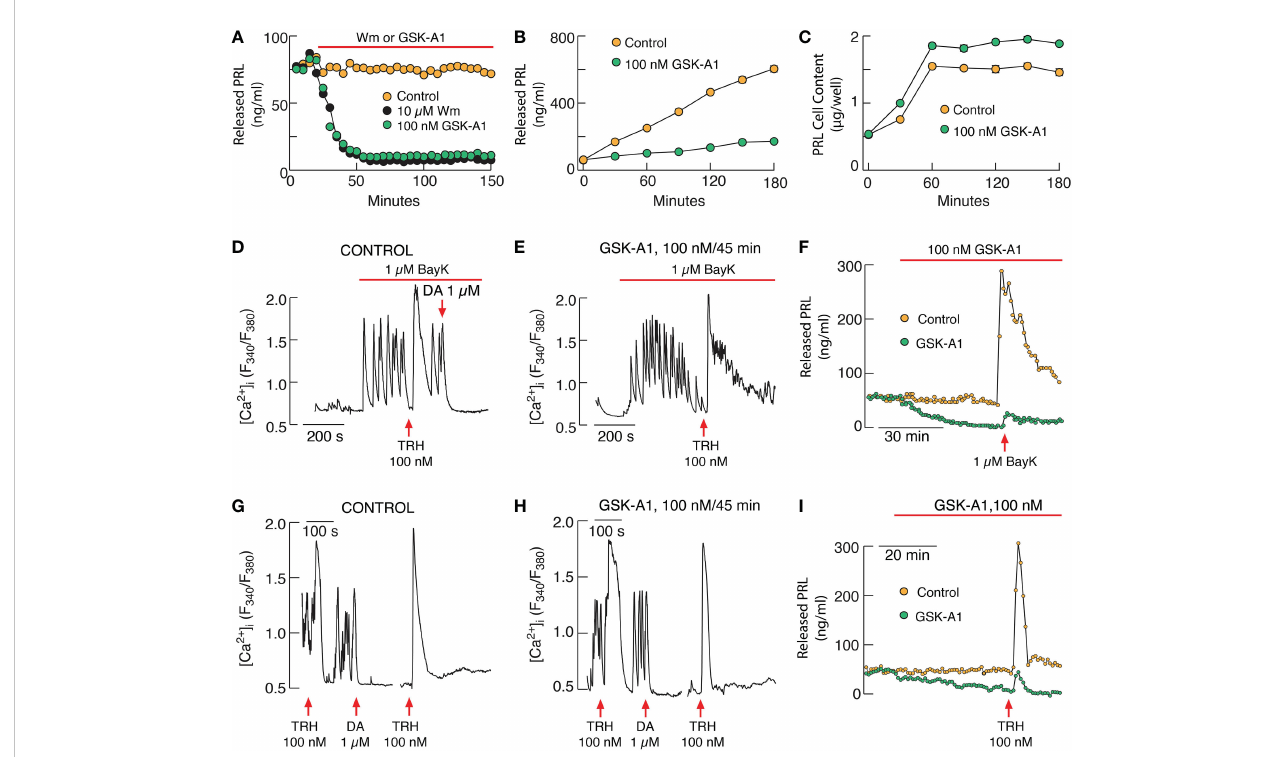
FIGURE 2 PI4KA controls basal and receptor-stimulated exocytosis in pituitary lactotrophs independently of PI(4,5)P2. (A – C) . Inhibition of basal prolactin (PRL) release by Wm and GSK-A1 in perfused (A) and static pituitary cells (B) without affecting de novo PRL synthesis (C) . (D – F) GSK-A1 also does not affect stimulated voltage-gated calcium in fl ux by L-type calcium channel agonist BayK 8644 (BayK) in pituitary lactotrophs (D, E) but inhibits BayK-stimulated PRL release in perfused pituitary cells (F) . (G – I) GSK-A1 does not inhibit thyrotropin-releasing hormone (TRH)-stimulated calcium mobilization in pituitary lactotrophs (G, H) but inhibits basal and TRH-stimulated PRL release in perfused pituitary cells (I) . DA, dopamine. Derived from reference